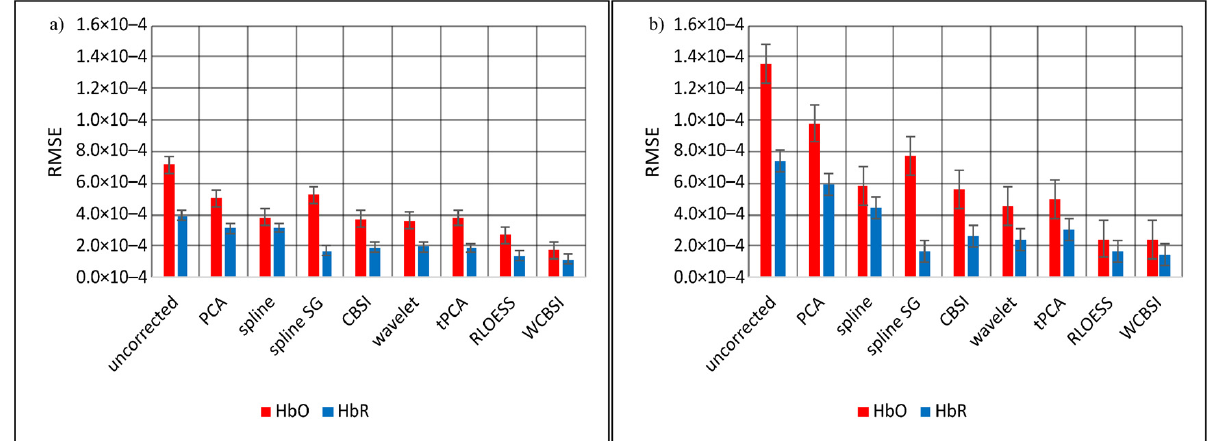
Figure 7. Average rooted mean square error (RMSE) between the MA corrected HbO and HbR signals and their respective reference signal. This is shown in ( a ) for the SHM responses and in ( b ) for the LHM responses. The RMSEs were calculated individually for each participant and then averaged. Error bars indicate standard error across participants.